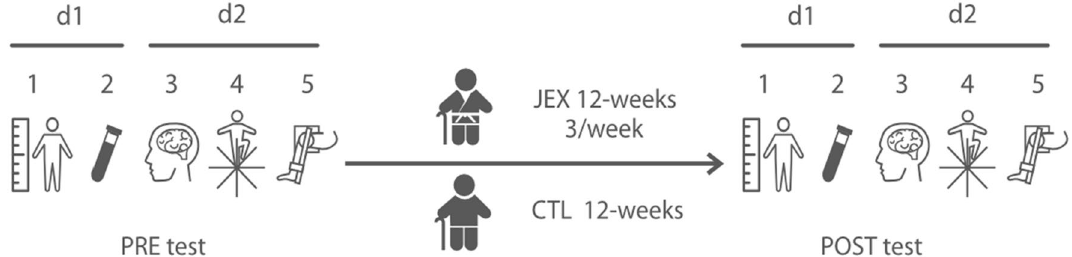
Figure 4. Study protocol: investigational timeline. 1 Anthropometric measurements, 2 Blood sampling, 3 Cognitive testing, 4 Body balance, 5 Muscle strength, d1 first day, d2 second